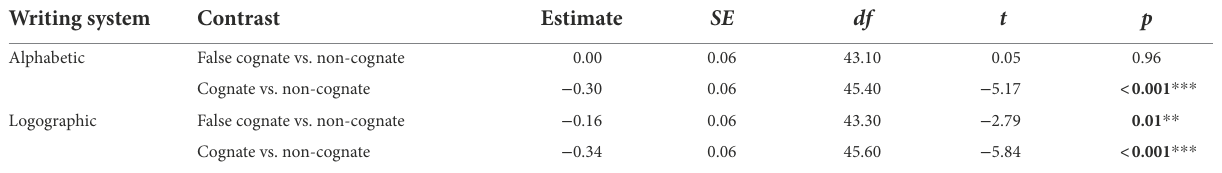
TABLE 7 Simple effects in the recognition tasks.